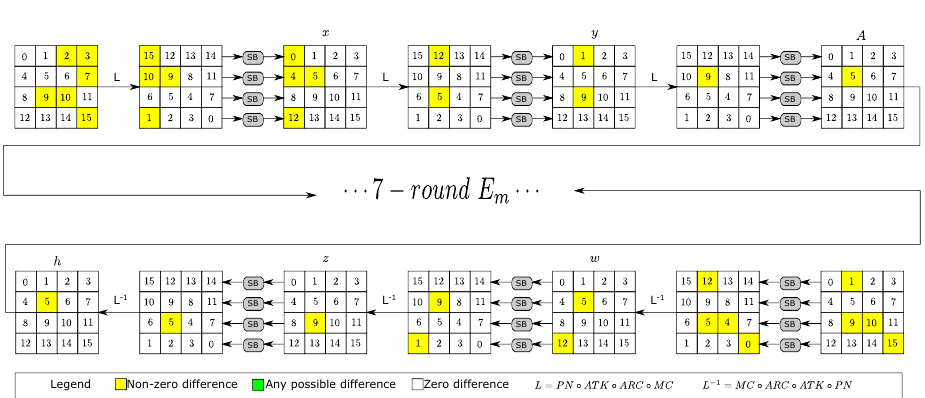
Figure 10: Example: a boomerang distinguisher for 13 rounds of